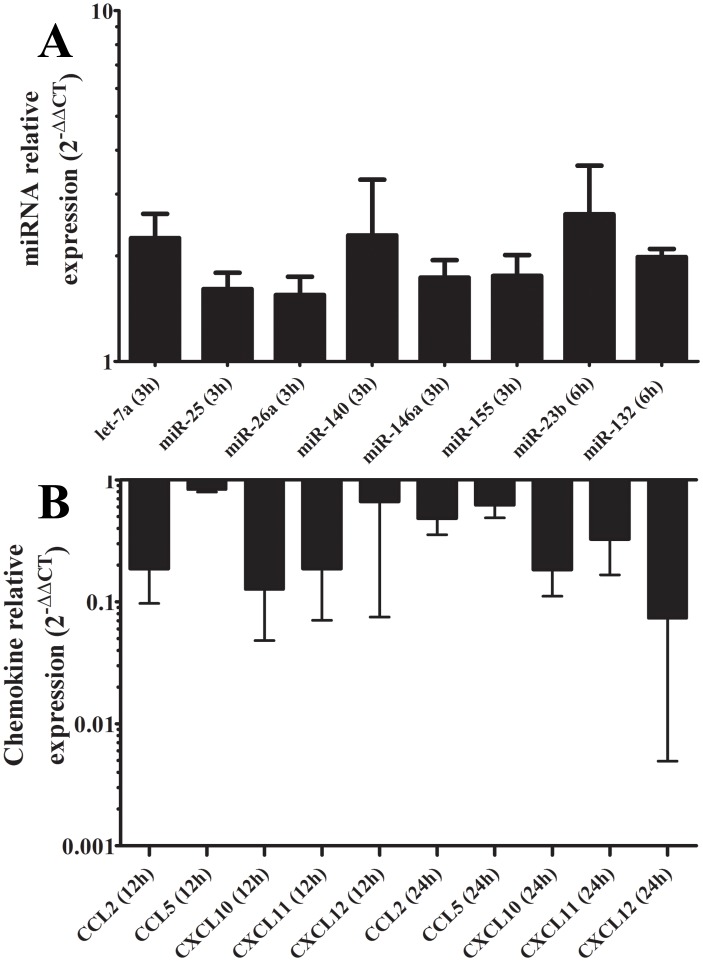
Negative correlation between expressions of an up-regulated set of miRNAs and their targeted chemokine transcripts.Expression means of let-7a, miR-25, miR-26a, miR-140, miR-146a and miR-155 at 3 h and miR-23b and miR-132 at 6 h post-infection of three healthy donors (D1, D2 and D3; panel A) is negatively correlated with CCL2, CCL5, CXCL10, CXCL11 and CXCL12 mRNA mean levels at 12 and 24 h post-infection (panel B) in L. major-infected human macrophages. Results were expressed using the 2−ΔΔCt method.